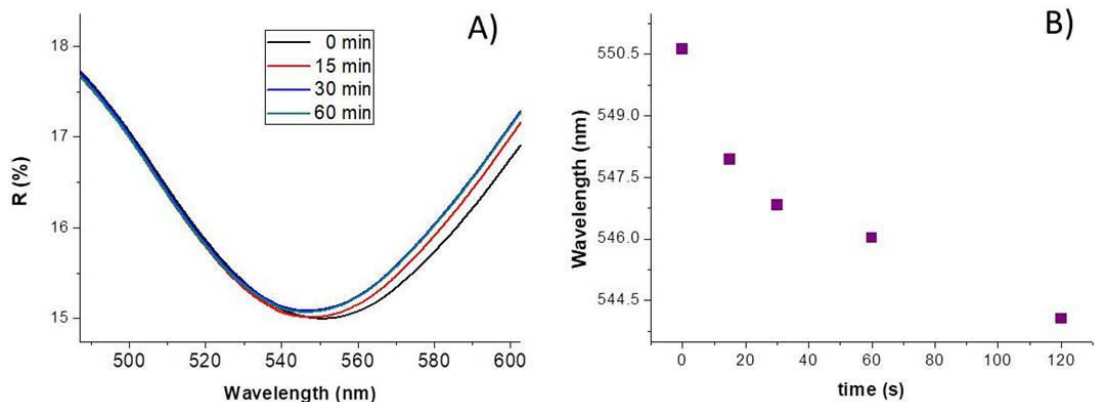
Figure 4. Comparison of UV-Vis diffuse reflectance spectra of AuNPs/TiO 2 layer in a 450–650 nm wavelength range at different exposure times to Hg 0 vapor pressure at 20 °C and 35%RH ( A ); a curve plot depicting the wavelength values of the AuNPs/TiO 2 layer at increasing exposure time to Hg 0 ( B ).